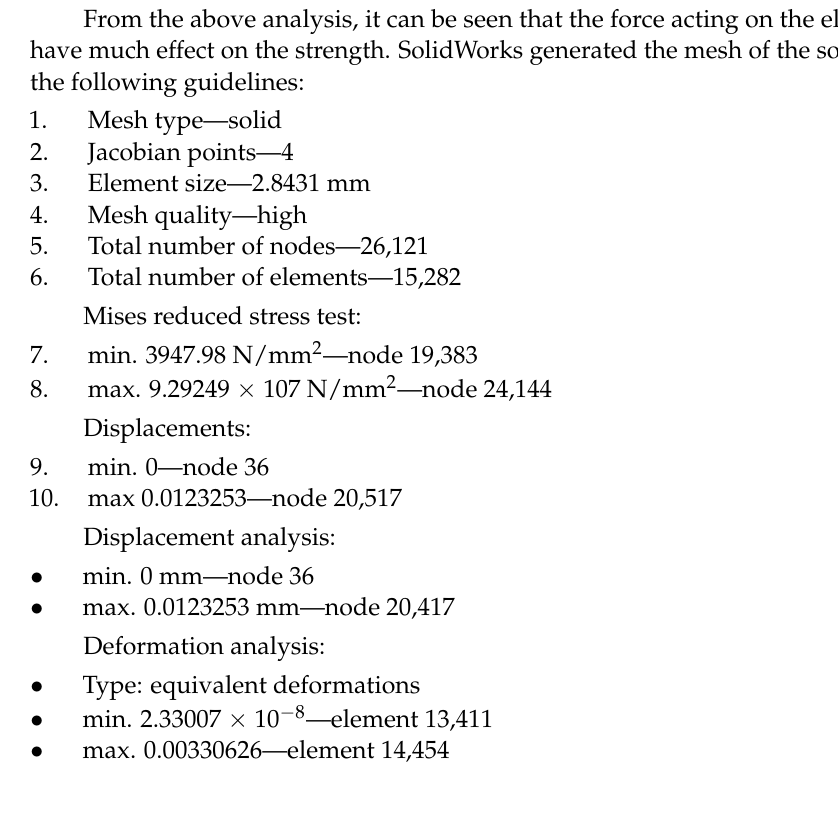
Figure 9. ( A ) — Pallet lock; ( B ) — Location of fixtures (green) and location of force application (purple); ( C ) — Pallet lock Figure 9. ( A )—Pallet lock; ( B )—Location of fixtures (green) and location of force application (purple); ( C )—Pallet lock solid solid mesh; ( D ) — Reduced stresses according to Mises; ( E ) — Displacement analysis; ( F ) — Deformation analysis; ( G ) — Fa- mesh; ( D )—Reduced stresses according to Mises; ( E )—Displacement analysis; ( F )—Deformation analysis; ( G )—Fatigue tigue reading chart; ( H ) — Static analysis in FEM. reading chart; ( H ) — Static analysis in